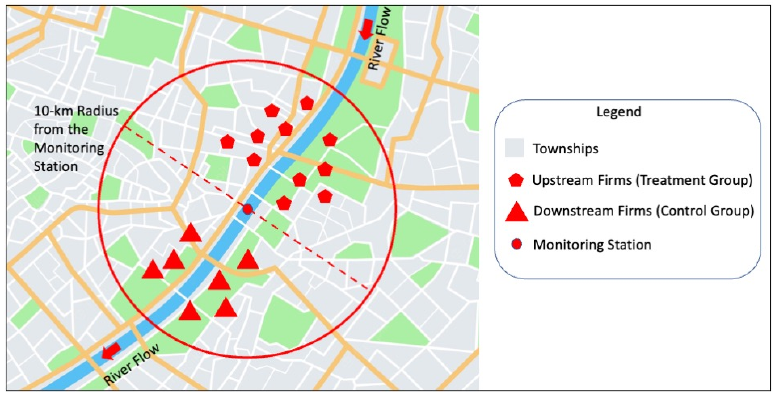
Figure 2. Diagram of regression discontinuity design strategy.